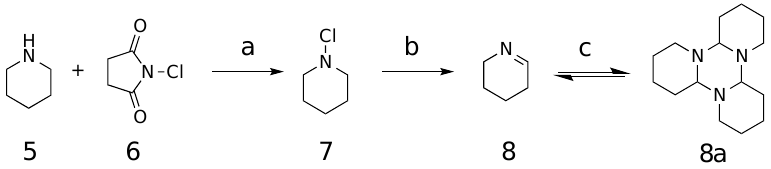
Scheme 1. The synthesis of Δ 1 -piperidein intermediate. Reaction conditions and reagents: ( a ) ether, RT; ( b ) 20% KOH, ethanol, 0 ◦ C to RT; ( c ) 80% acetone, − 20 ◦